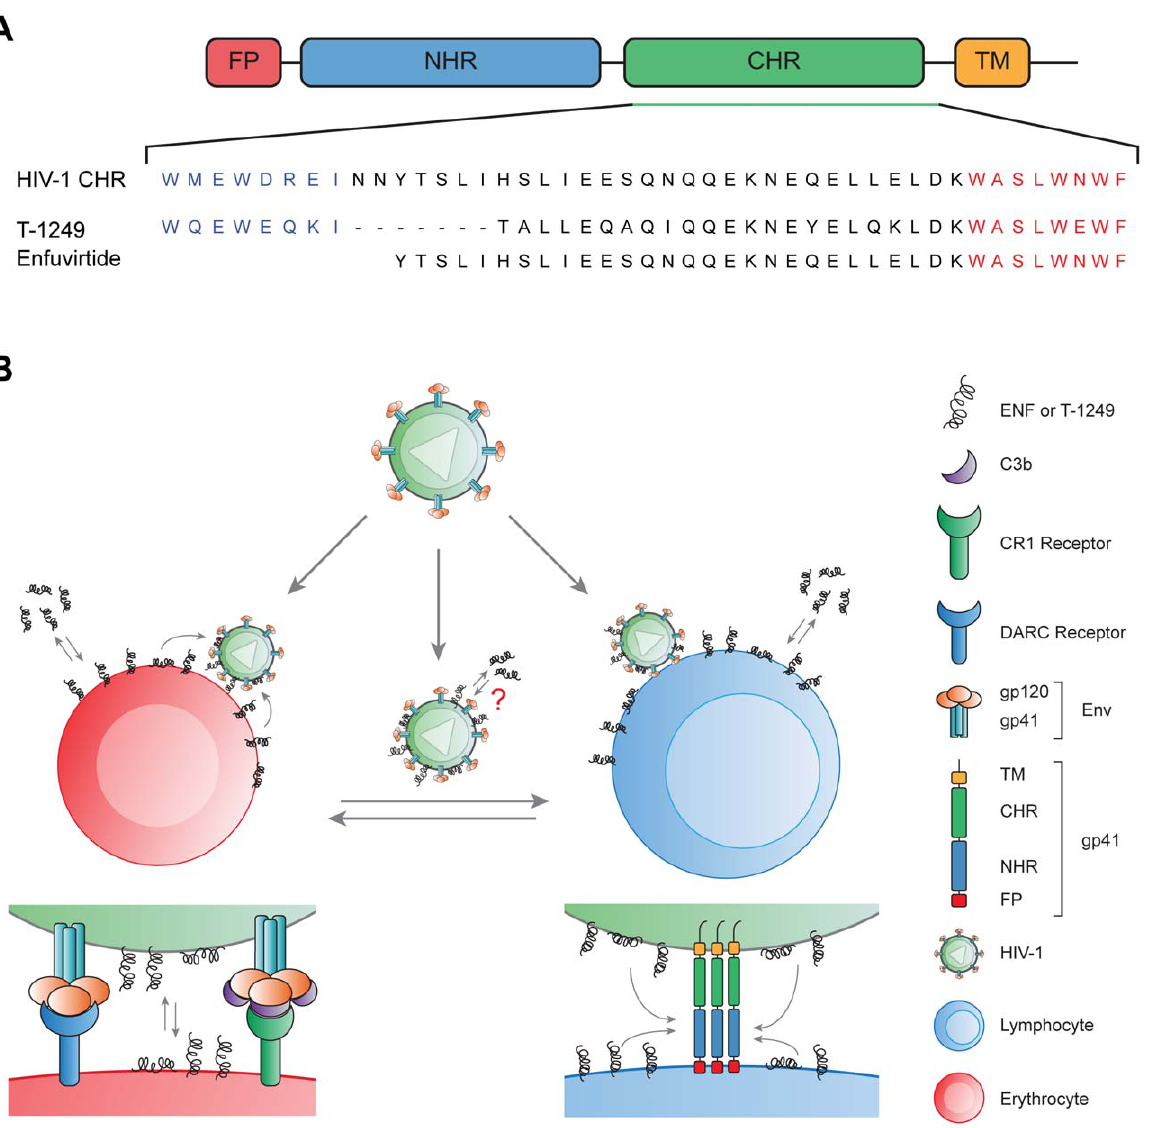
Figure 6. Proposed mode of action of enfuvirtide and T-1249 in circulation with blood cells. A) Sequence alignment of enfuvirtide and T- 1249 with native gp41 (PDB code: 1ENV), showing the pocket binding domain (PBD) in blue and the putative lipid binding domain (LBD) close to the membrane proximal region in red. B) Peptides partition to the membranes of circulating blood cells creating a peptide-rich environment, when the virus interact both with erythrocytes and lymphocytes. HIV associates with erythrocytes via DARC receptor or complement opsonized virus via CR1. Exchanges of peptide between cells and virus and partition of peptide directly to the viral membrane can occur. When infecting the preferential CD4 + T cells, the membrane binding of peptide inhibitors should facilitate its interaction with the exposed conformation of gp41, preventing the 6-helix bundle formation. If the virus is internalized and fuses with the cell membrane at the endosome level, as recently described [27], the partition of the peptides to the membranes ensures that a considerable amount of peptides enters upon endocytosis in order to be available during the intracellular fusion event.